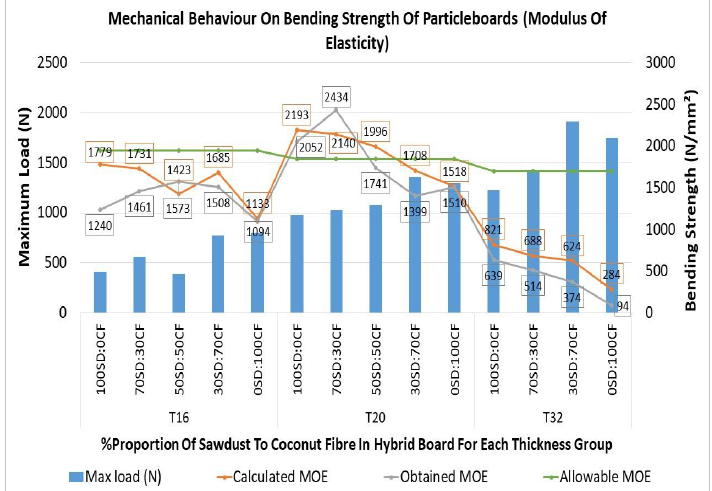
Figure 15. Mechanical Performances on Bending Strength of Particleboards (Modulus of Elasticity) .